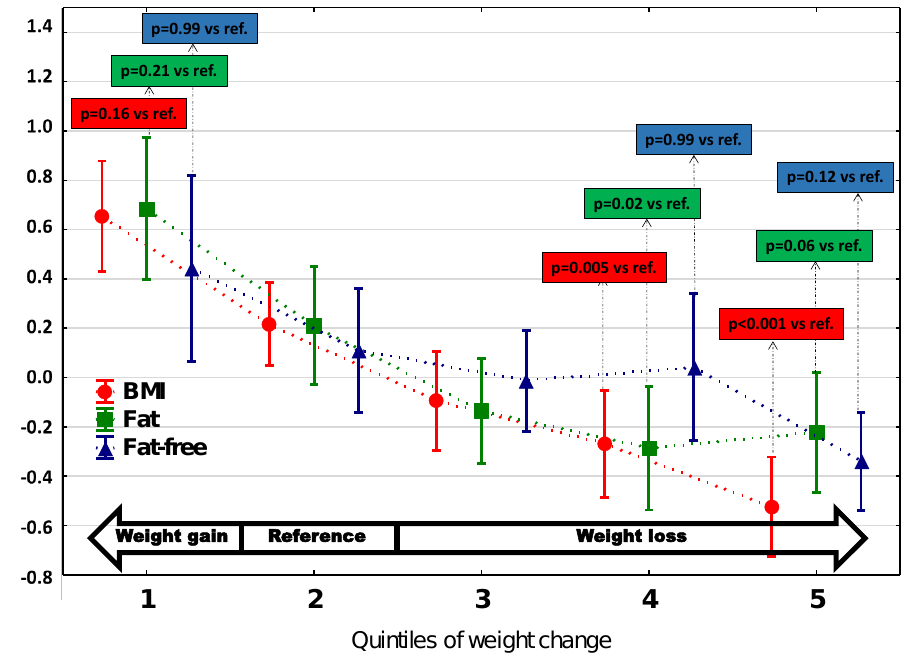
Figure 2. Standardized values of BMI, fat and fat-free tissue according to quintiles of WC. Serum levels of 25[OH]D correlated with WC in pooled subgroups with weight loss (Q3 to Q5) ( r = 0.16, p < 0.05), but not in patients with weight gain ( r = 0.09, NS). There was a nonlinear association between WC and 25[OH]D deficiency / insu ffi ciency, with the lowest probability of these abnormalities occurring in patients with no WC and an increase toward both extremes of WC. Figure 3 shows polynomial approximation of 25[OH]D deficiency probability across whole spectrum of